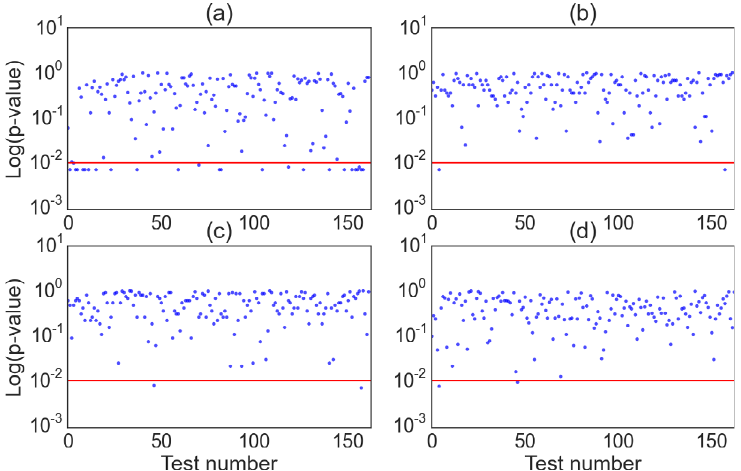
Fig. 4. Scatter plot of the p -value results for 188 tests performed on binary sequences that were generated by various methods, the red line denotes the threshold for which the p -value indicates that the sequence has not passed a given test. (a) The sequence generated using LED light passing through a polarizing beamsplitter. (b) Same sequence after applying the von Neumann ’ s algorithm for bias removal. (c) Pseudo-random numbers generated with the rand() method in the C programming language. (d) Random numbers taken from the true random number generator implemented by Hotbits [11]. We can see how von Neumann ’ s algorithm greatly improves the performance of our random number